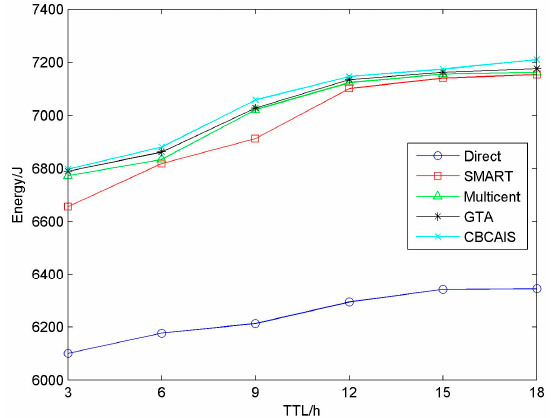
Figure 16. Energy for varying TTL.